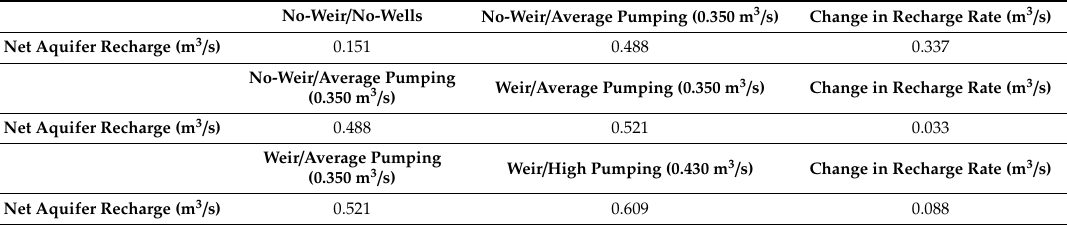
Table 2. Simulated changes in river recharge from pristine conditions to completion of the Serchio River RBF managed aquifer recharge